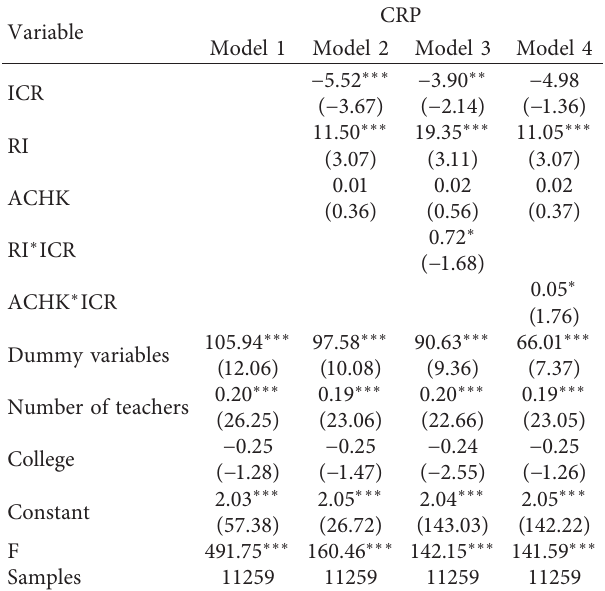
Table 3: Robustness test